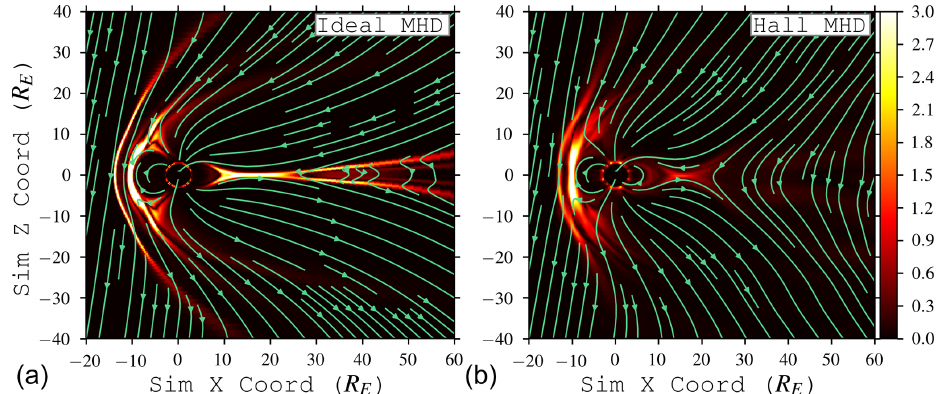
Figure 2. Normalized current density magnitude (cid:107) J (cid:107) in the simulation xz plane at y = 0 for both ideal (a) and Hall (b) MHD. Streamlines show in-plane magnetic field. Adding the Hall term induces out-of-reconnection-plane flows (Fig. 1); the resulting tail convection causes the magnetotail current sheet to vary along the x direction across the tail width ( y ) (see, e.g., Figs. 7 and 9 for examples of (cid:107) J (cid:107) spatial variation in the xy